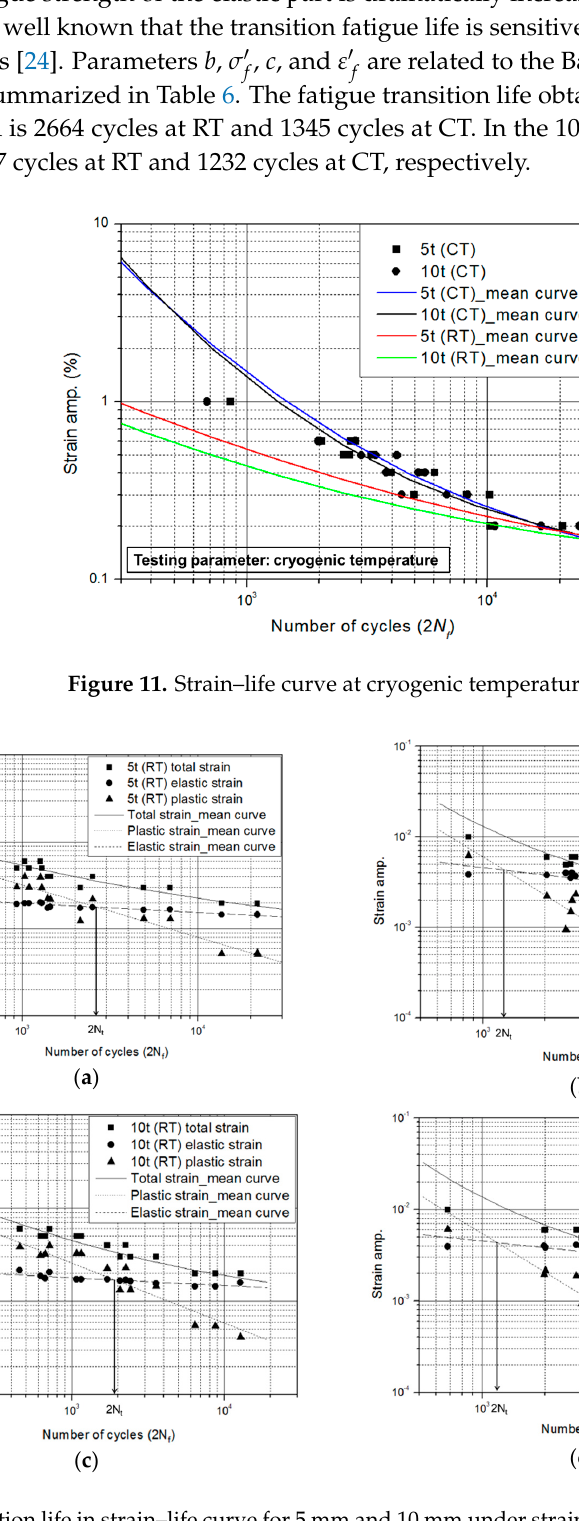
Figure 12. Transition life in strain–life curve for 5 mm and 10 mm under strain ratio R = 0. ( a ) Transition life (2 N t) for 5 t at RT; ( b ) Transition life (2 N t) for 5 t at CT; ( c ) Transition life (2 N t) for 10 t at RT; ( d ) Transition life (2 N t) for 10 t at CT.